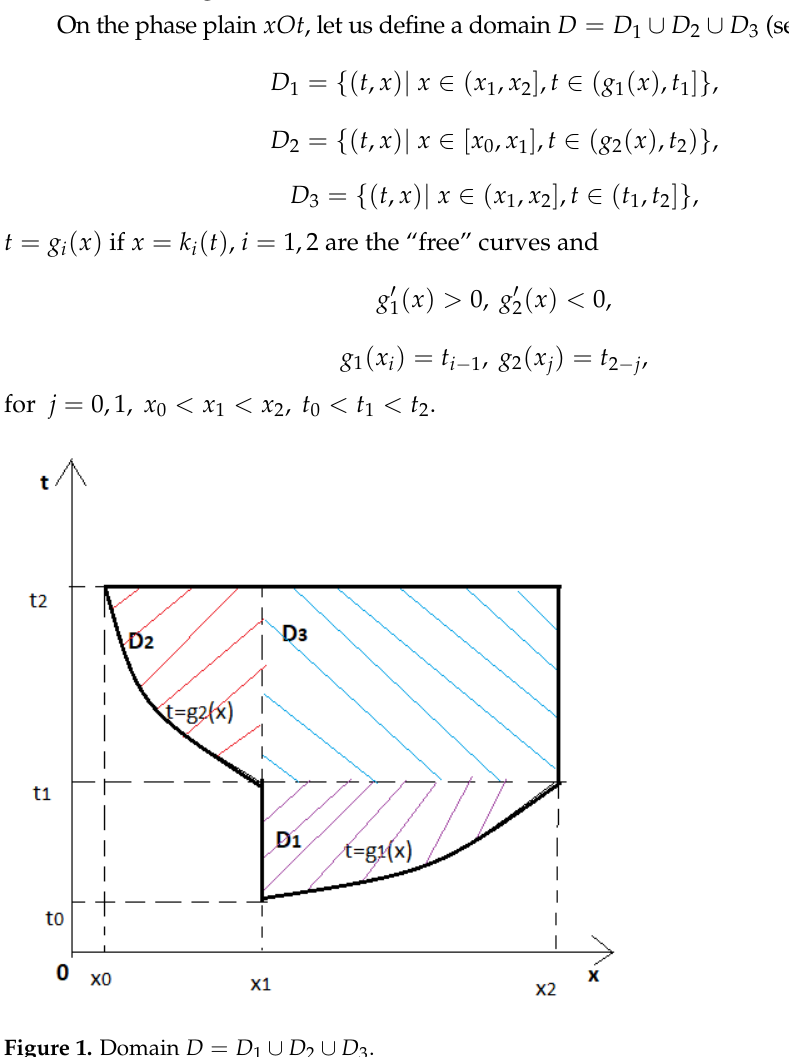
Figure 1. Domain D = D 1 ∪ D 2 ∪ D 3